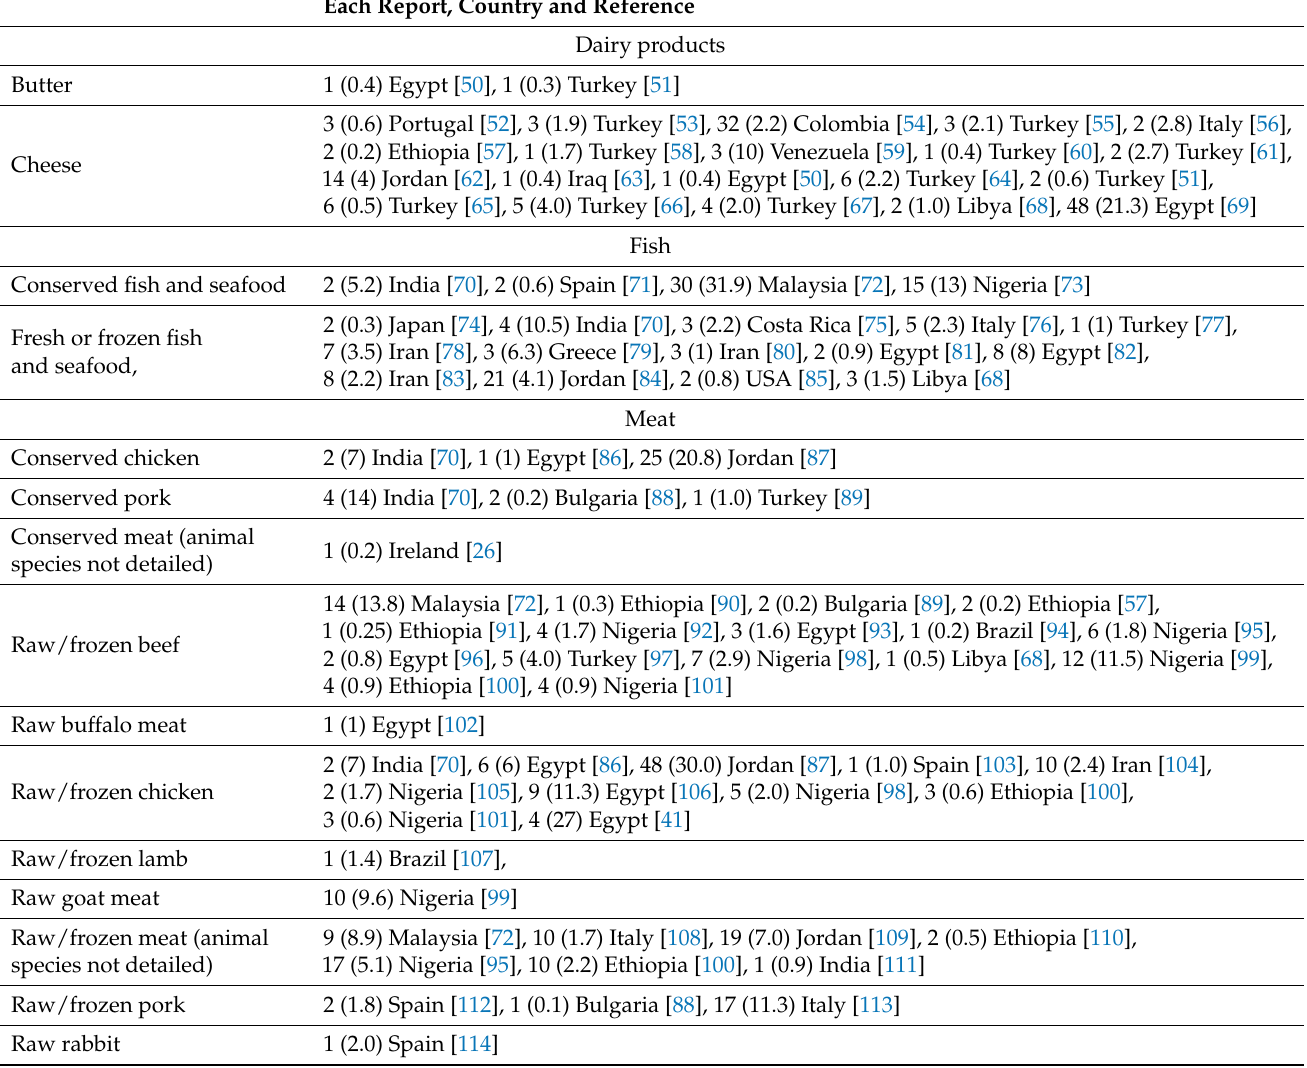
Table 1. Food products in which the presence of L. ivanovii was reported, number of positive samples, positivity rate (percentage of positive samples on the total number of samples analyzed in each study), country of isolation and reference. Number of Samples Positive for L. ivanovii , Positivity Rate (%) on All Analyzed Samples for Food Matrix Each Report, Country and Reference Dairy